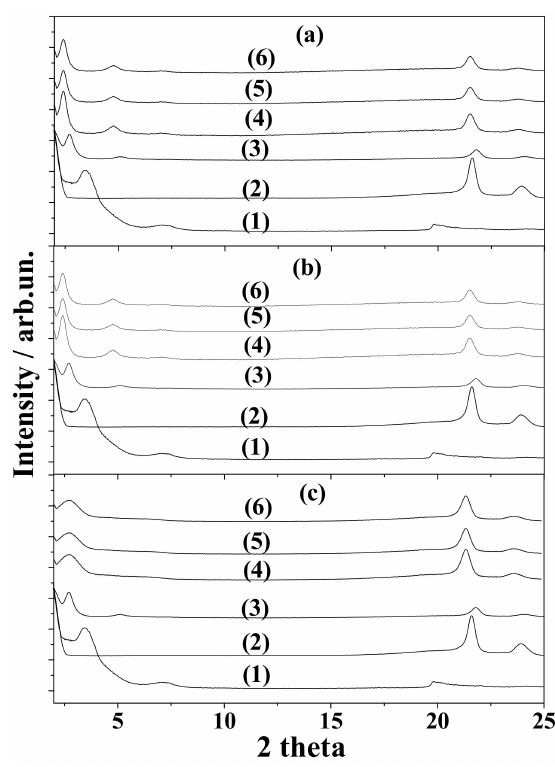
Figure 2. XRD patterns of ( a ) LDPEOrgMtTO, ( b ) LDPEOrgMtOO, and ( c ) LDPEOrgMtBO films. (1) OrgMt as-received, (2) pure LDPE film, (3) “blank” LDPEOrgMt film, (4) LDPEOrgMtEO20 film, (5) LDPEOrgMtEO40 film. and (6) LDPEOrgMtEO80 film. Table 1. The d 001 spacing values along with the Young’s Modulus E, the ultimate strength σ (uts), and the % elongation at break % ε b mean (standard deviation) values of all LDPENaMtEO and LDPEOrgMtEO nanocomposite films as well as of the LDPENaMt, the LDPEOrgMt, and of the pure LDPE